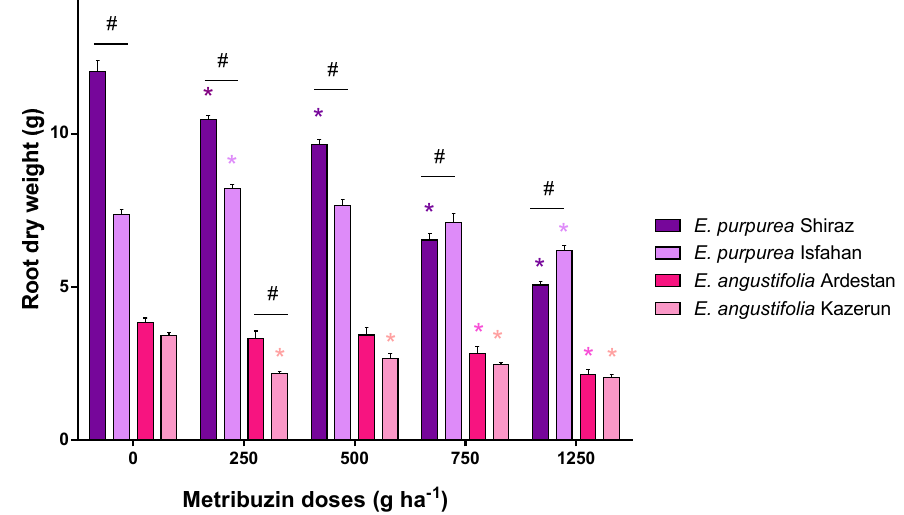
Figure 3. Effect of different metribuzin doses on root dry weight of Echinacea purpurea and Echinacea angustifolia species. Data are shown as the mean ± SEM, and ordinary two-way ANOVA followed by Dunnett’s multiple comparisons test was used for statistical significance; * p < 0.005 vs. control (0 g ha − 1 metribuzin). Significant differences between Echinacea cultivars are indicated with #.